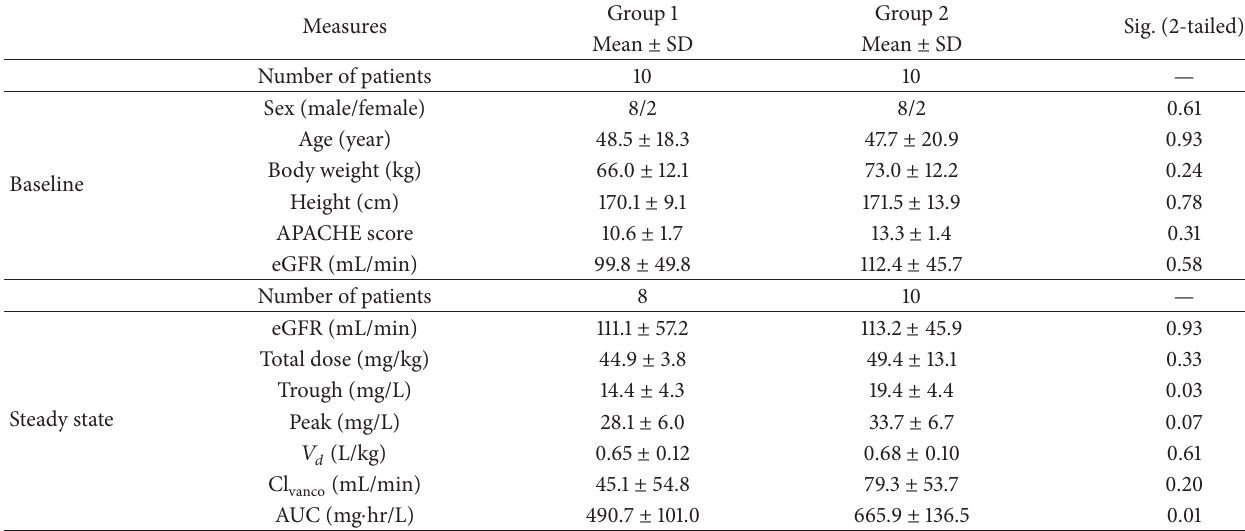
Table 1: Demographic and pharmacokinetic parameters in two groups of patients. Measures